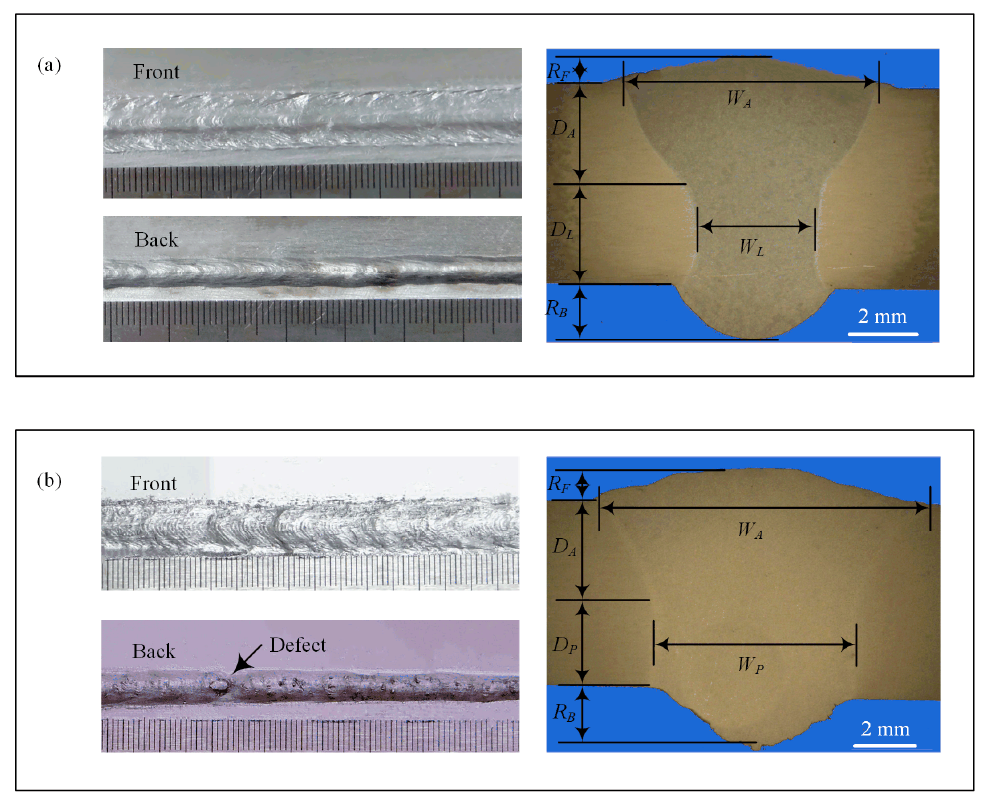
Figure 4. Cross-sections and weld appearances obtained with their optimized welding parameters. ( a ) laser-CMT hybrid weld; ( b ) plasma-CMT hybrid weld.